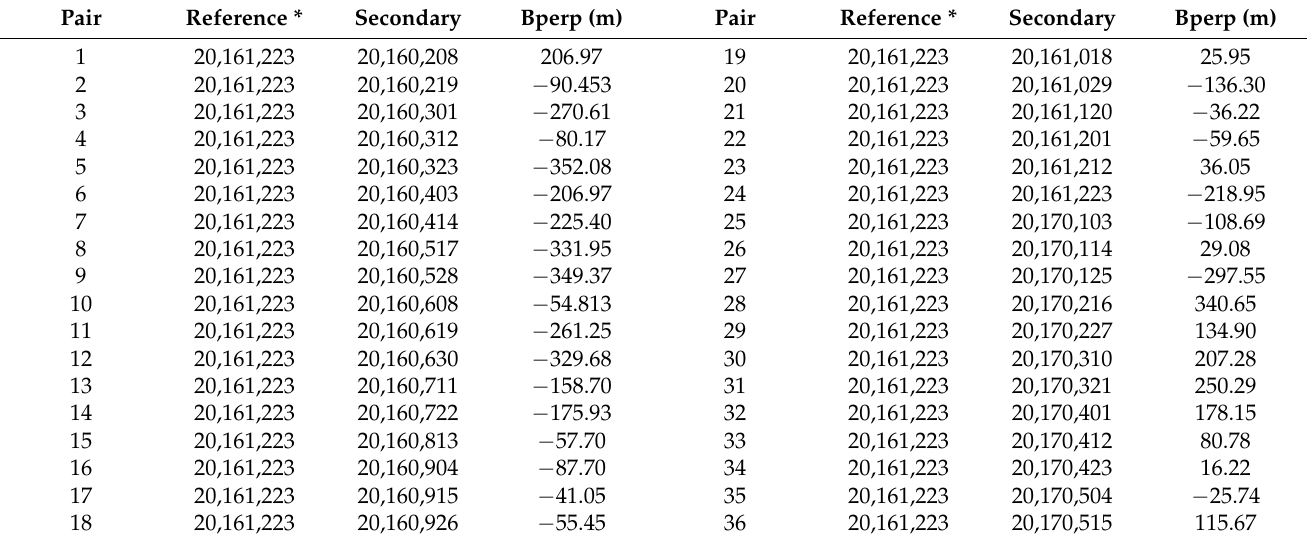
Table 2. The acquisition dates of the Reference and Secondary TSX images, perpendicular baseline (Bperp) and time interval relative to the Reference image.